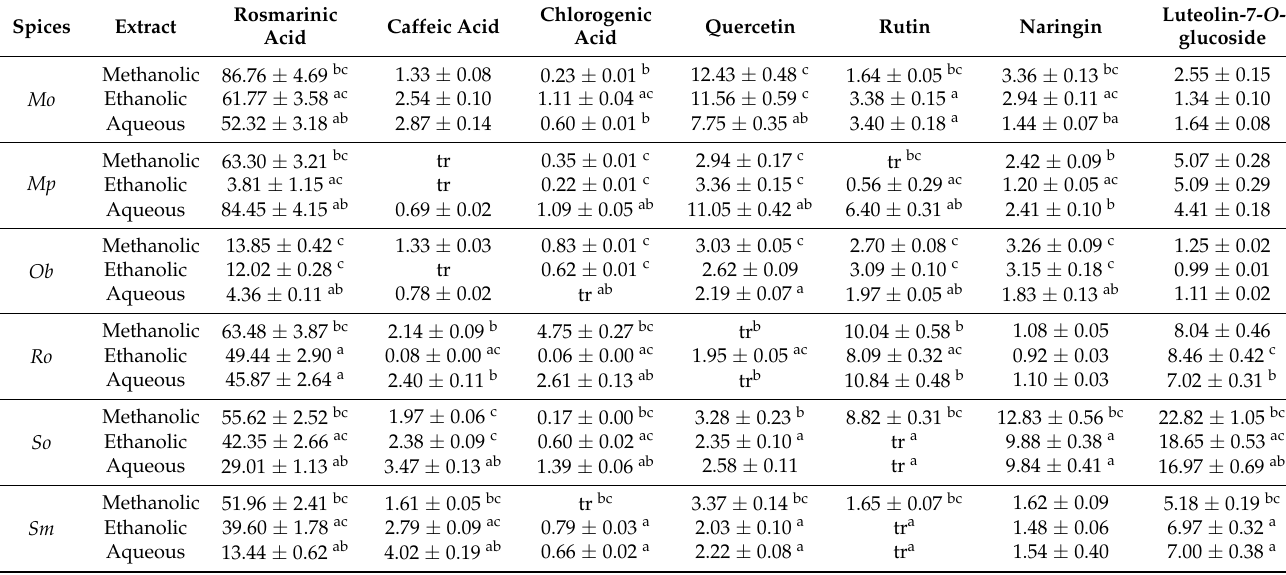
Table 2. Chemical analysis of the extracts assessed using HPLC-DAD technique. The results are presented as mg/g dry extract, as means ± standard deviation.